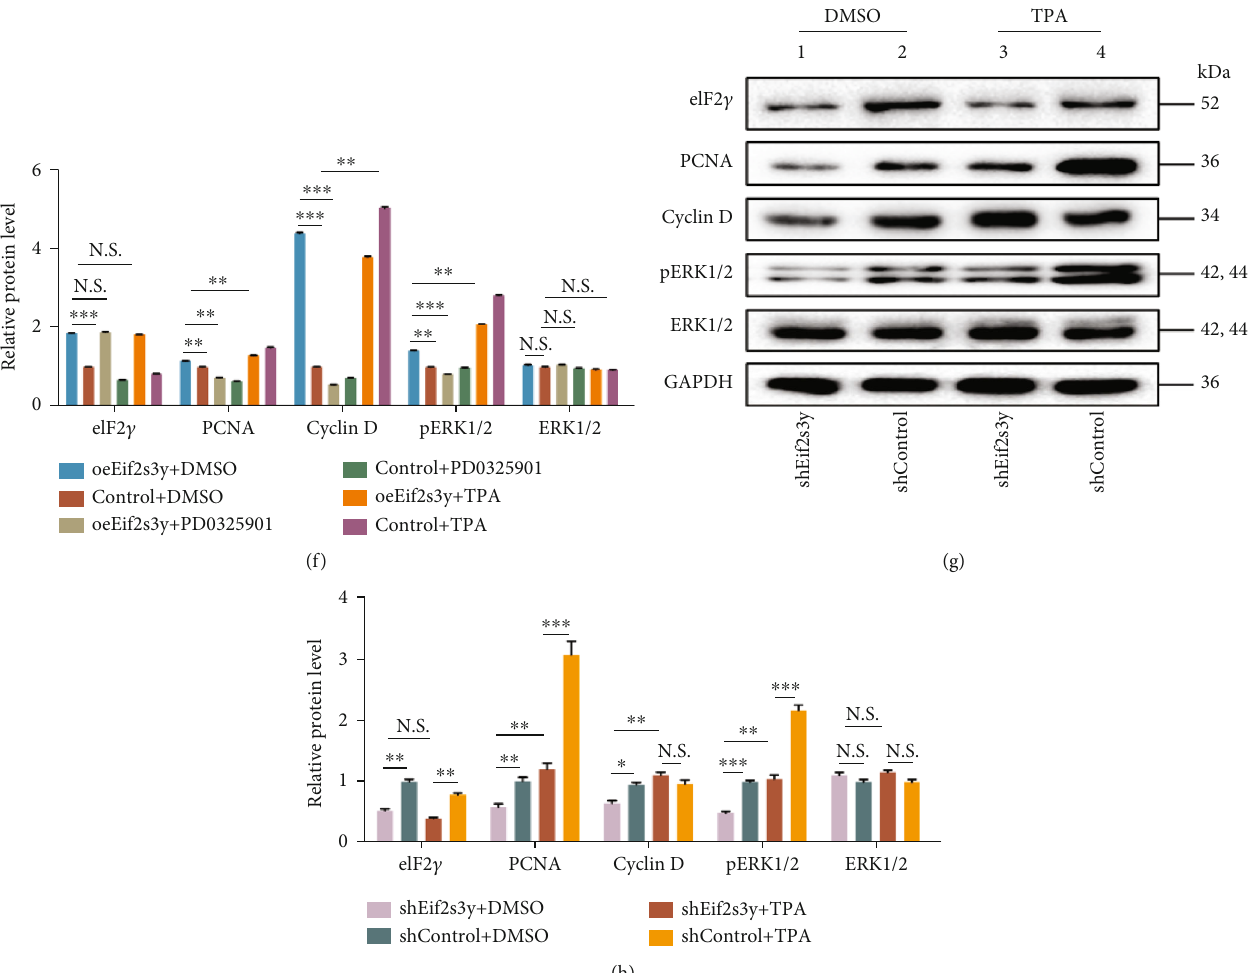
Figure 7: Eif2s3y promotes SSC proliferation by activating the ERK signaling pathway. Control and oeEif2s3y SSCs were treated with 1 μ M ERK pathway inhibitor PD0325901 or 10 μ M ERK pathway activator TPA for 24 h, respectively. shControl and shEif2s3y SSCs were treated with 10 μ M ERK pathway activator TPA for 24h. DMSO was used for the control group. (a) EdU incorporation assay of Control and oeEif2s3y SSCs added with ERK pathway inhibitor PD0325901 or DMSO. Scale bar, 400 μ m. (b) The percentage of EdU-positive cells to total cells. The proportion of positive cells is positively correlated with the cell proliferation rate. (c) EdU incorporation assay of shControl and shEif2s3y SSCs added with ERK pathway activator TPA or DMSO. Scale bar, 400 μ m. (d) The percentage of EdU-positive cells to total cells. (e) Western blotting detected the protein expression of eIF2 γ , PCNA, Cyclin D, pERK1/2, and ERK1/2 in SSCs treated as indicated. GAPDH was used as a loading control. (f) Gray intensity analysis of WB results normalized to GAPDH in (e). (g) Western blotting detected the protein expression of eIF2 γ , PCNA, Cyclin D, pERK1/2, and ERK1/2 in SSCs treated as indicated. (h) Gray intensity analysis of WB results normalized to GAPDH in (g). Data are presented as mean ± SD and are represented by three independent repetitions; ∗ P < 0 : 05 , ∗∗ P < 0 : 01 , and ∗∗∗ P < 0 : 001 ; N.S. means P ≥ 0 : 05